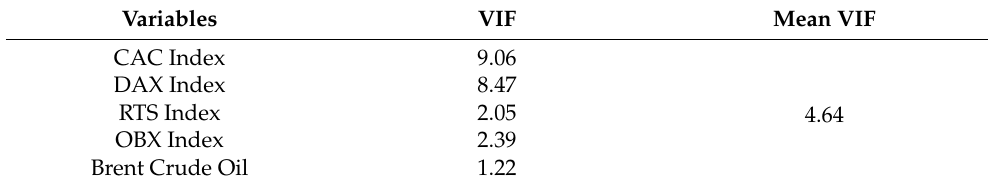
Table 2. Results of Multicollinearity